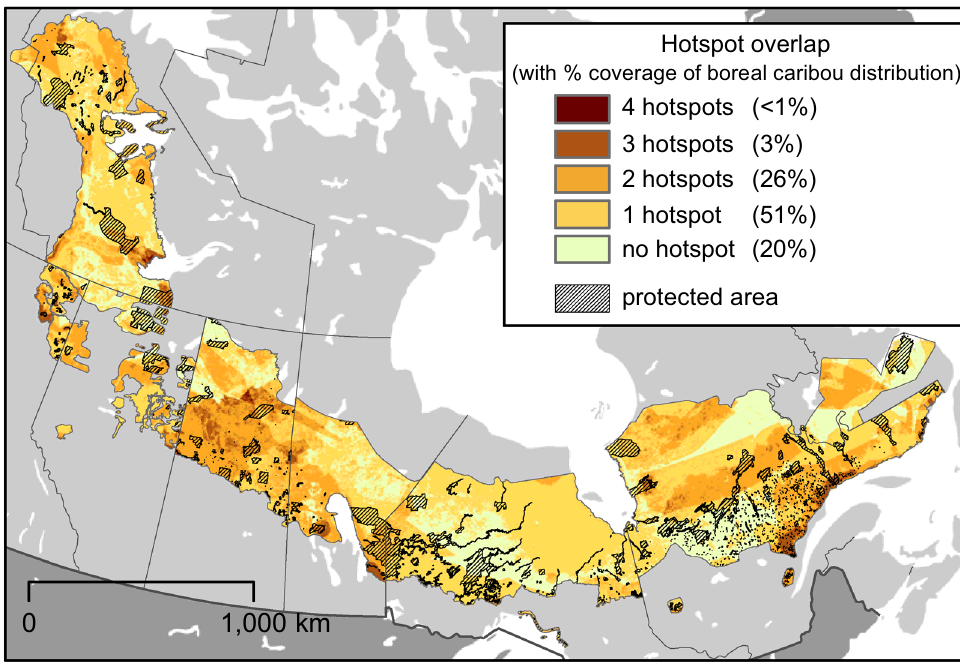
Figure 5. Spatial overlap among the different hotspots across the distribution of boreal caribou. The hatched areas show the existing protected and conserved areas network.